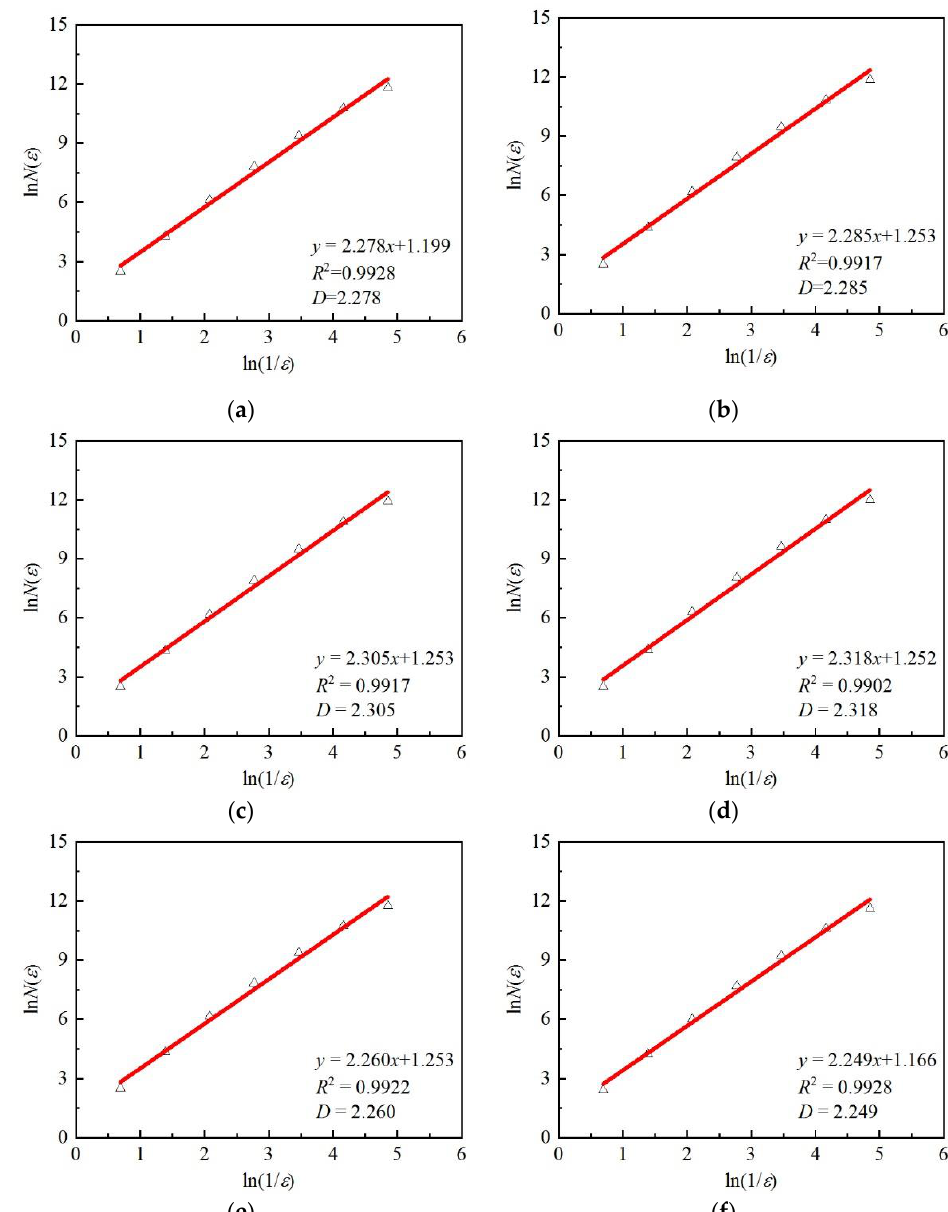
Figure 7. Fractal dimensions of images at various corrosion depths: ( a ) t w = 0.096 mm, ( b ) t w = 0.250 mm, ( c ) t w = 0.387 mm, ( d ) t w = 0.467 mm, ( e ) t w = 0.609 mm, ( f ) t w = 0.647 mm. Table 5. Fitting equation and significance test of the relationship between image features after rust removal (fractal dimension) and corrosion depth.